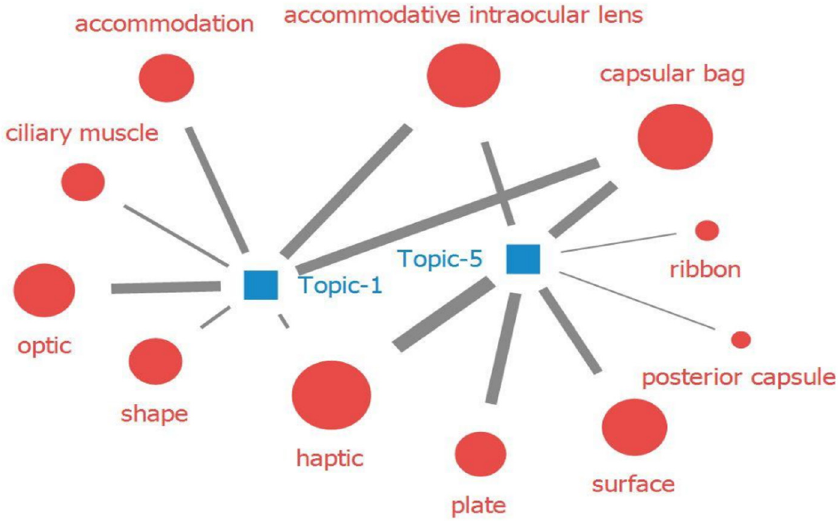
Figure 7. Topic modeling results showing the high correlation among haptic, accommodation, and surface.